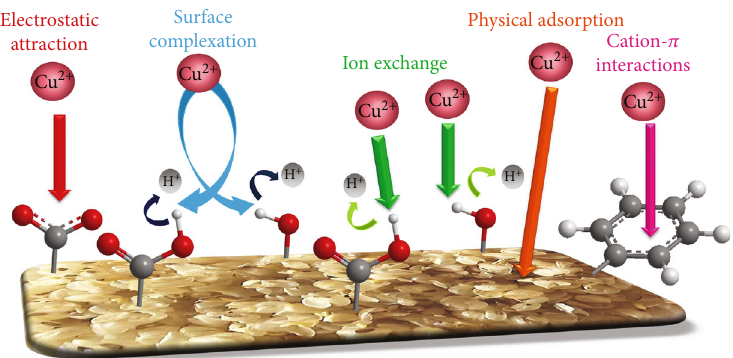
Figure 5: Graphical interpretation of the possible interaction between Cu 2+ and soybean hulls ’ surface.